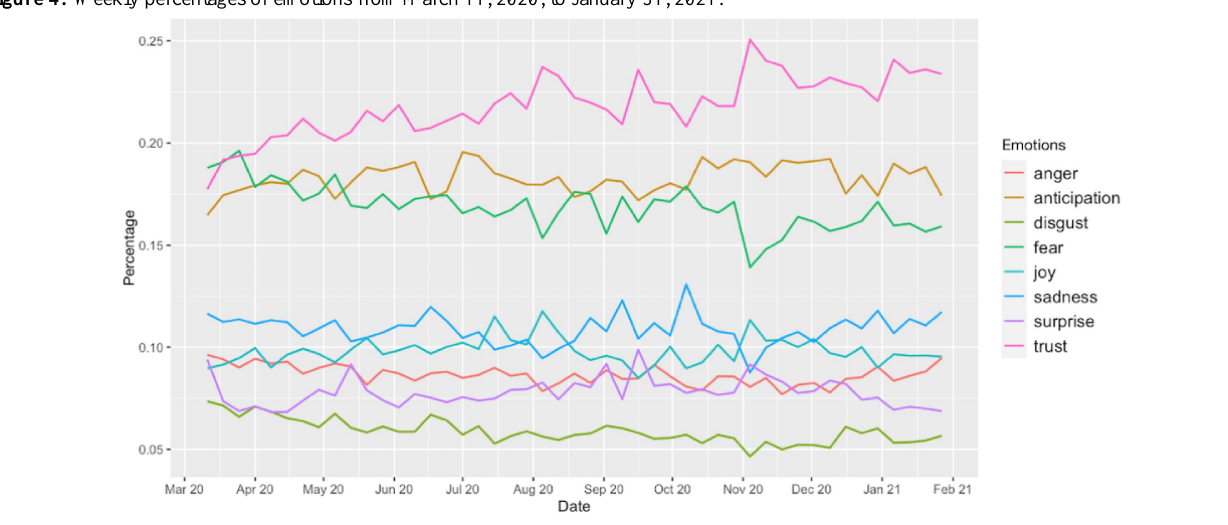
Figure 4. Weekly percentages of emotions from March 11, 2020, to January 31,